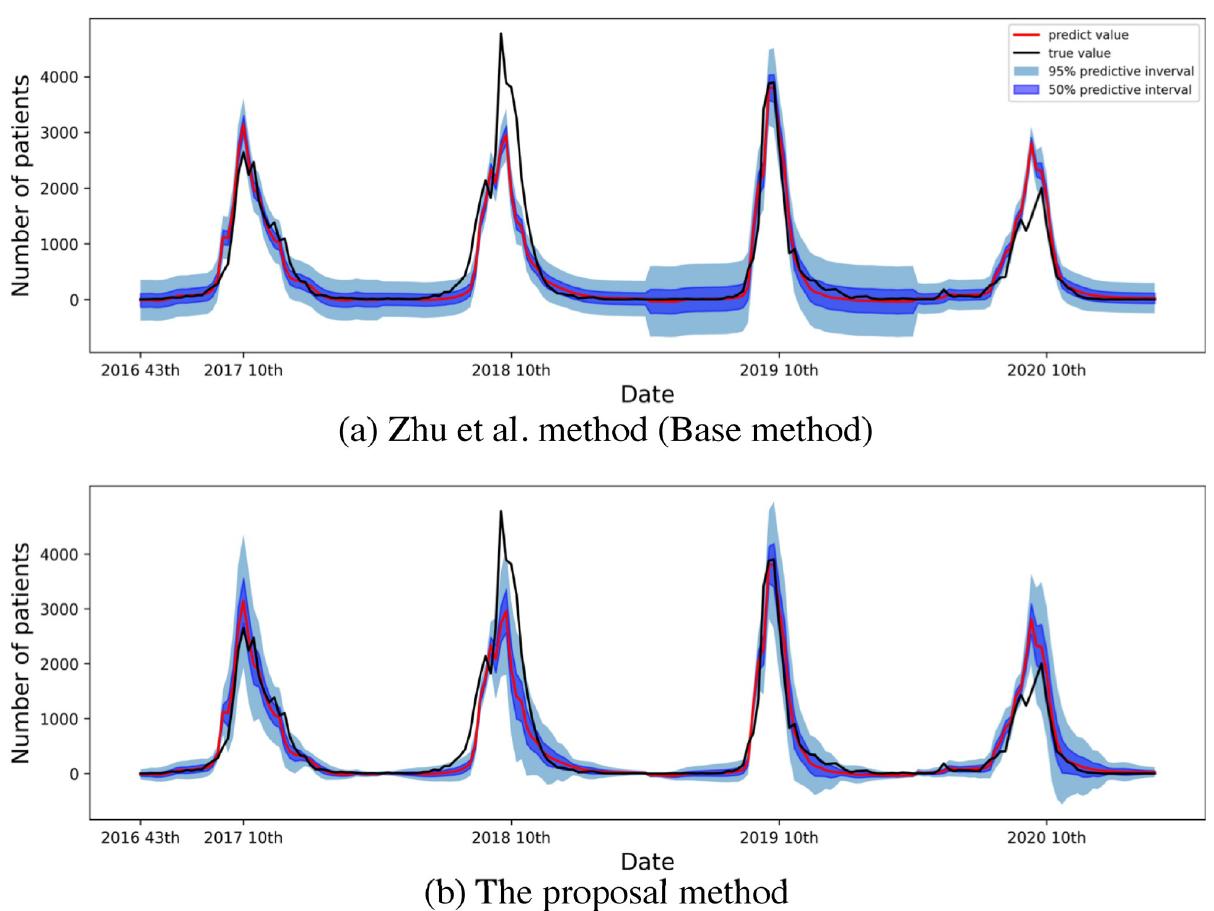
Fig 6. Time series with prediction interval of influenza patients (black line). Predictive values of the two weeks in advance prediction by our proposed model (red line) in the Okayama prefecture. Prediction intervals by (a) Zhu’s method and (b) proposed method. Light blue and dark blue sections show the 95% and 50% prediction intervals,